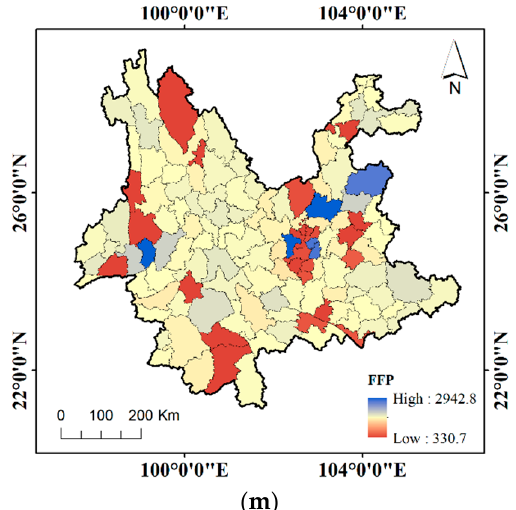
Figure 3. Explanatory factors of flash flood risk. ( a ) Annual Maximum 3 h Precipitation ( b ) Annual Maximum 24 h Precipitation; ( c ) Annual Precipitation ( d ) Digital Elevation Model; ( e ) Slope ( f ) River Density; ( g ) Vegetation Coverage ( h ) Curve Number; ( i ) Topographic Wetness Index ( j ) Soil Moisture; ( k ) Population ( l ) Gross Domestic Product; ( m ) Flash Flood Preventions.